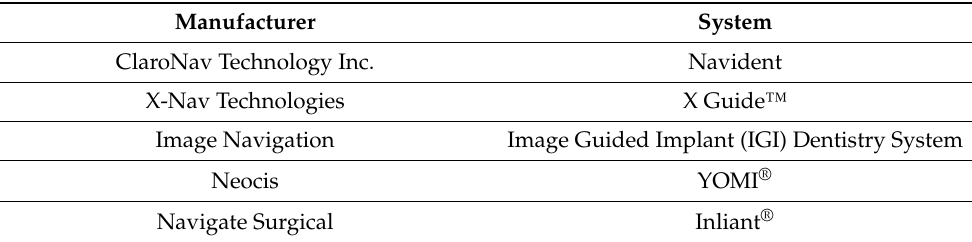
Table 4. Example of dynamic navigation implant systems available in the